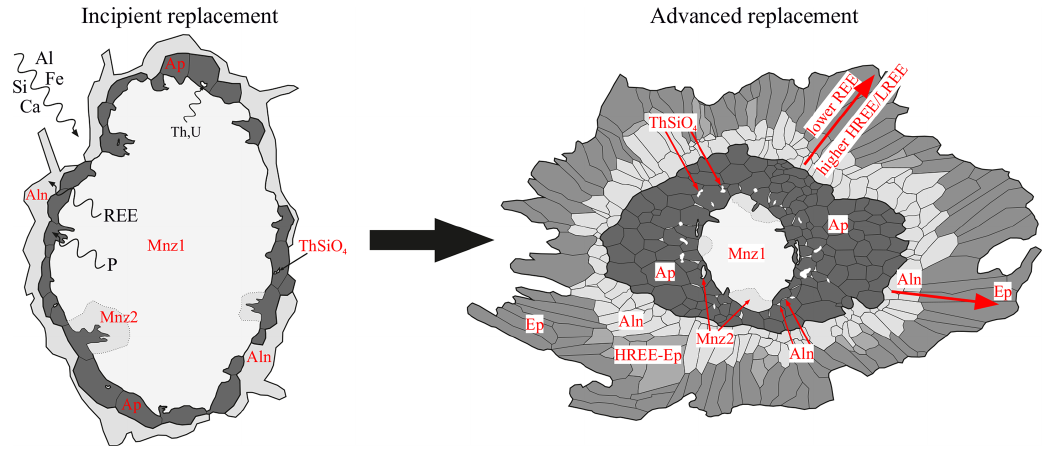
Figure 15. Sketch of observed corona microstructures with incipient and advanced replacement of